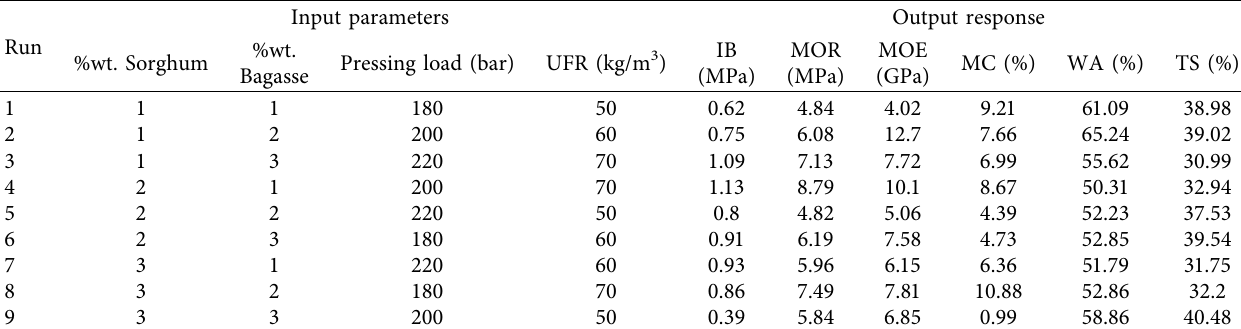
Table 3: Summary of experimental results for various conditions.